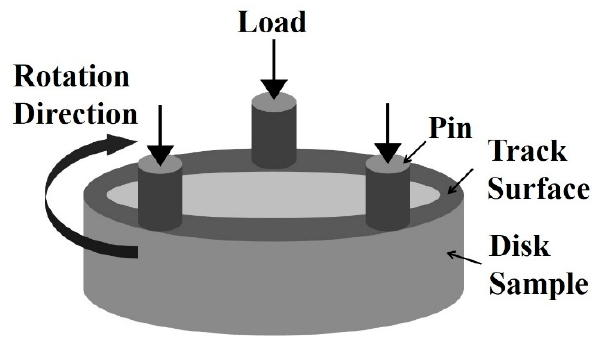
Figure 1. Schematic of the pin-on-disc tester.